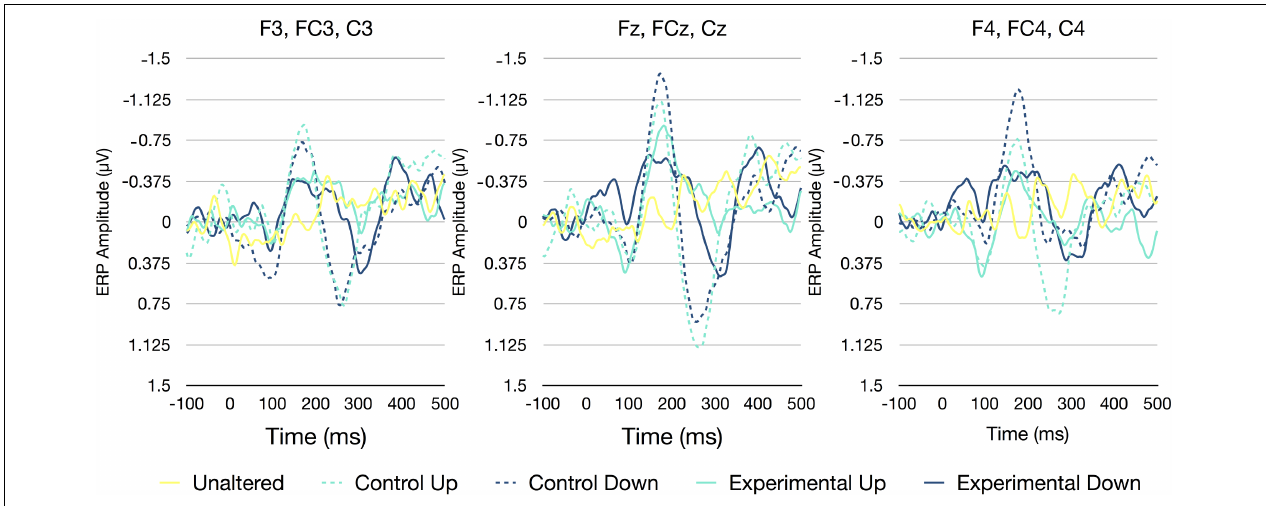
FIGURE 3 | ERP waveforms averaged across all participants and all electrodes [left (F3, FC3, and C3), medial (Fz, FCz, and Cz), and right (F4, FC4, and C4)]. Separate lines represent each of the five perturbation categories unaltered (0/0), control up (0/50), control down (0/ − 50), experimental up (50/100), and experimental down